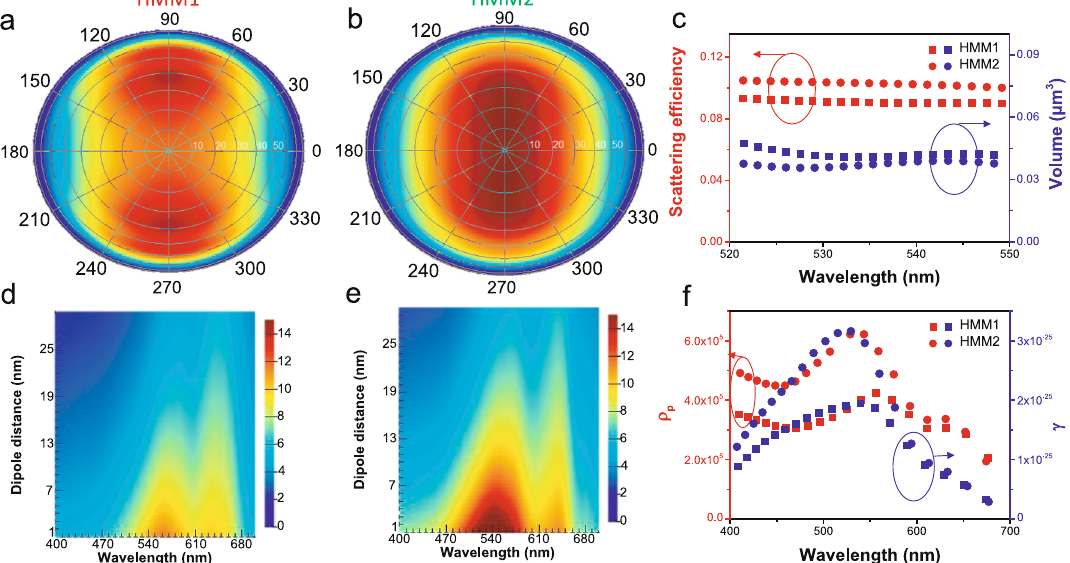
Fig. 3 Theoretical analysis. a , b The far- fi eld angular distributions for the HMM1 and HMM2, respectively. c The scattering ef fi ciency (marked as the red color) and the mode volume (marked as the blue color) of the PNCs on top of the HMM1 and HMM2 substrates. Purcell factors for a perpendicular dipole emitter placed on top of the d HMM1 and e HMM2 substrates. The dipole-HMM separation distance was varied from 1 to 30 nm. f The local density of states ( ρ p ) (marked as the red color) and the spontaneous decay rate ( γ ) (marked as the blue color) were calculated by the method of dyadic Green ’ s function. The simulated spectra cover the wavelength range from 400 to 700